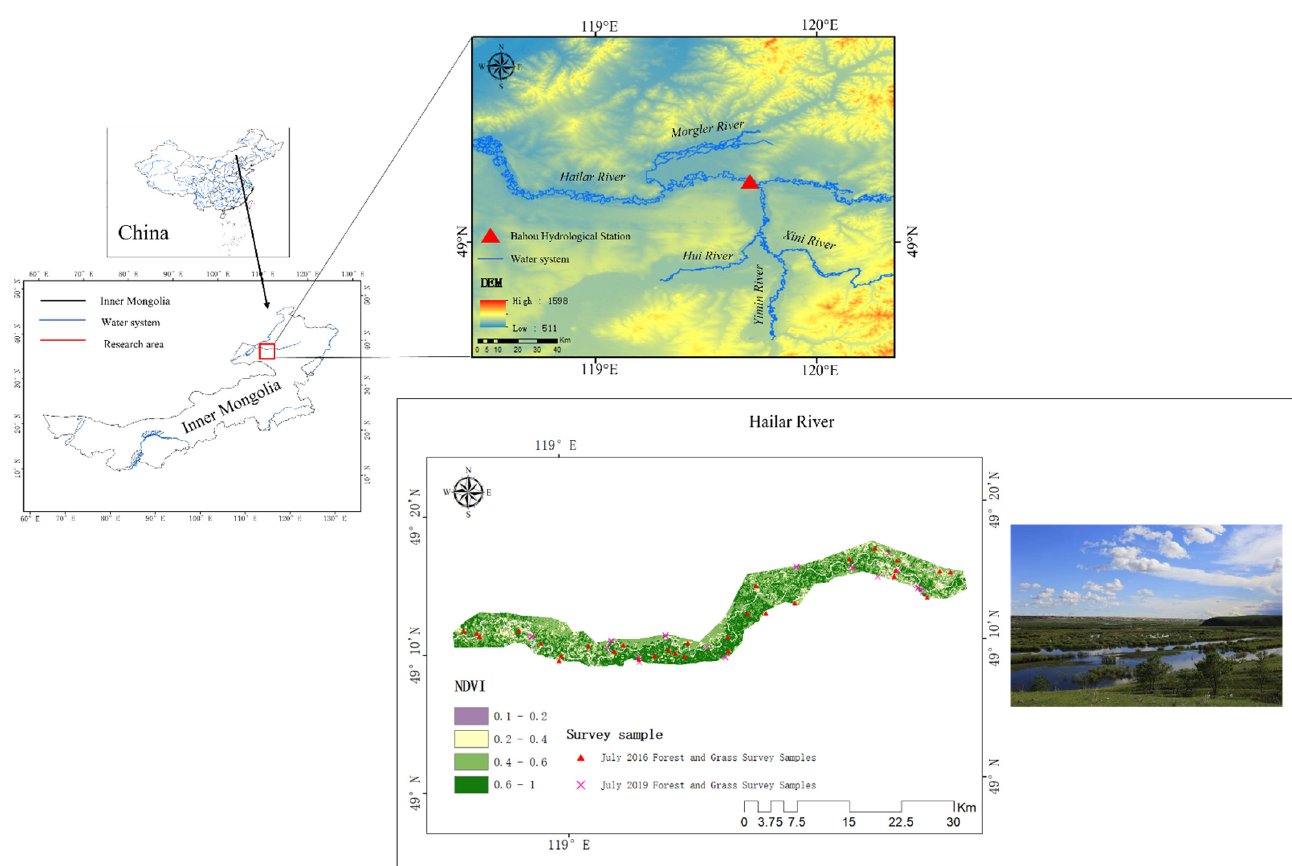
Figure 1. Location of the study site.